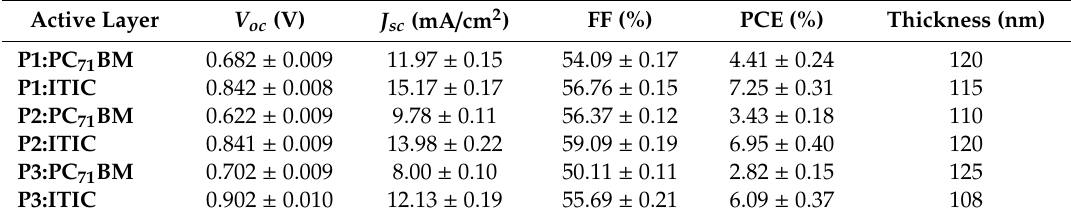
Table 3. Photovoltaic performances of the bulk heterojunction solar